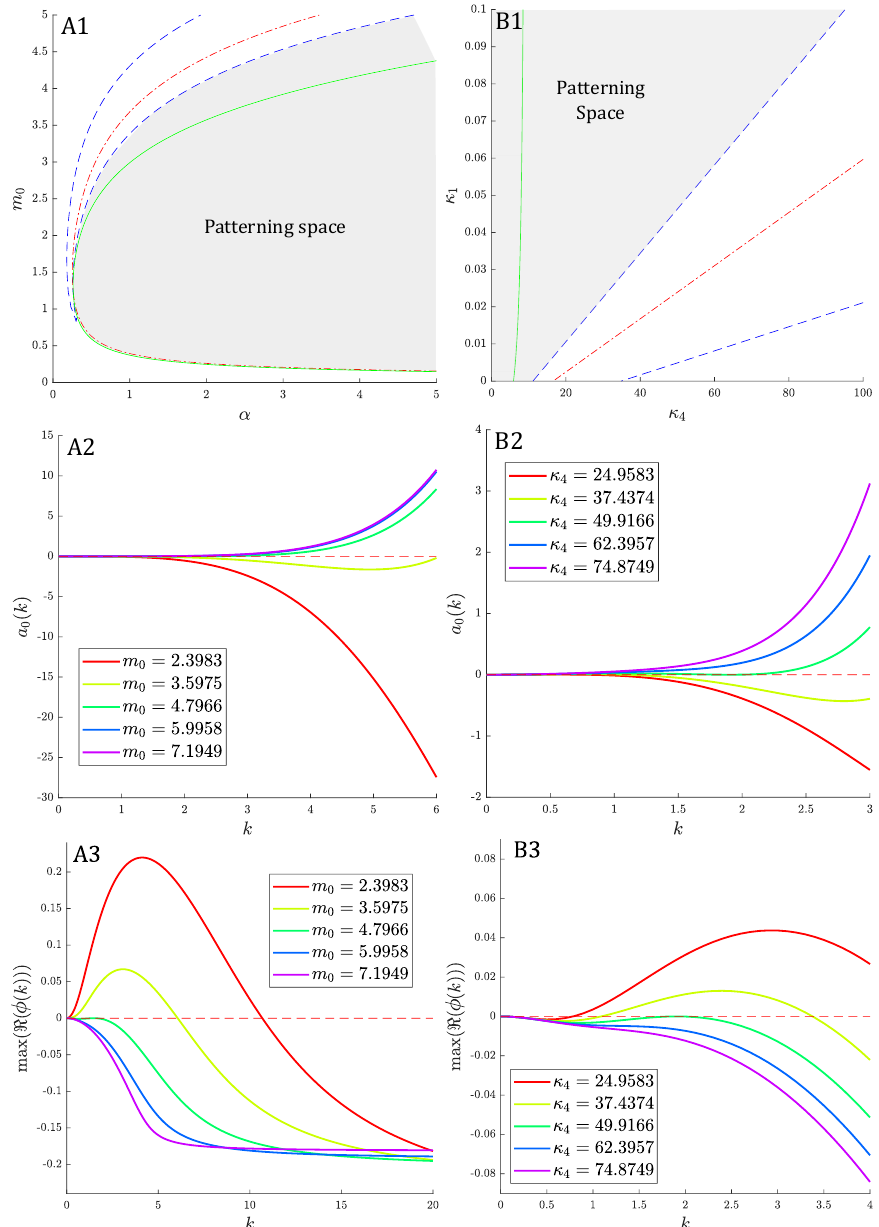
Figure 1. Patterning space, parameter condition and dispersion relations for the uncoupled poro– mechano–chemical model. ( A1 ) Predicted patterning space for a selected interval in ( m 0 , α )